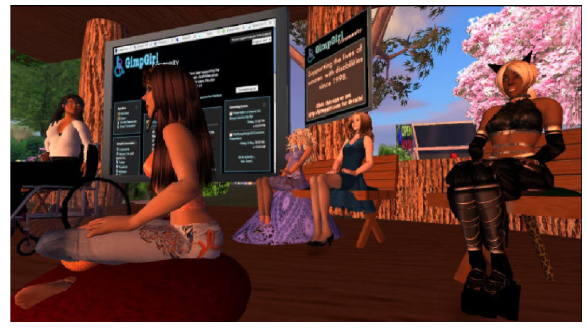
Figure 2. GimpGirl meeting held in Second